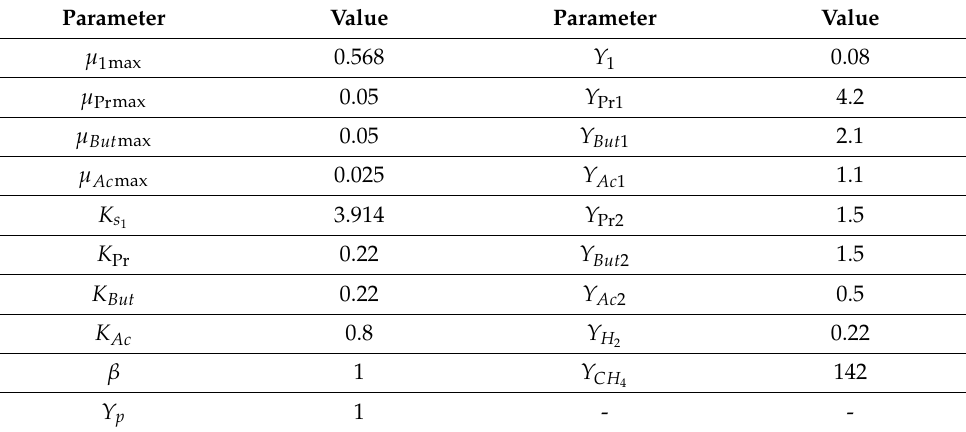
Table 1. Model parameters.